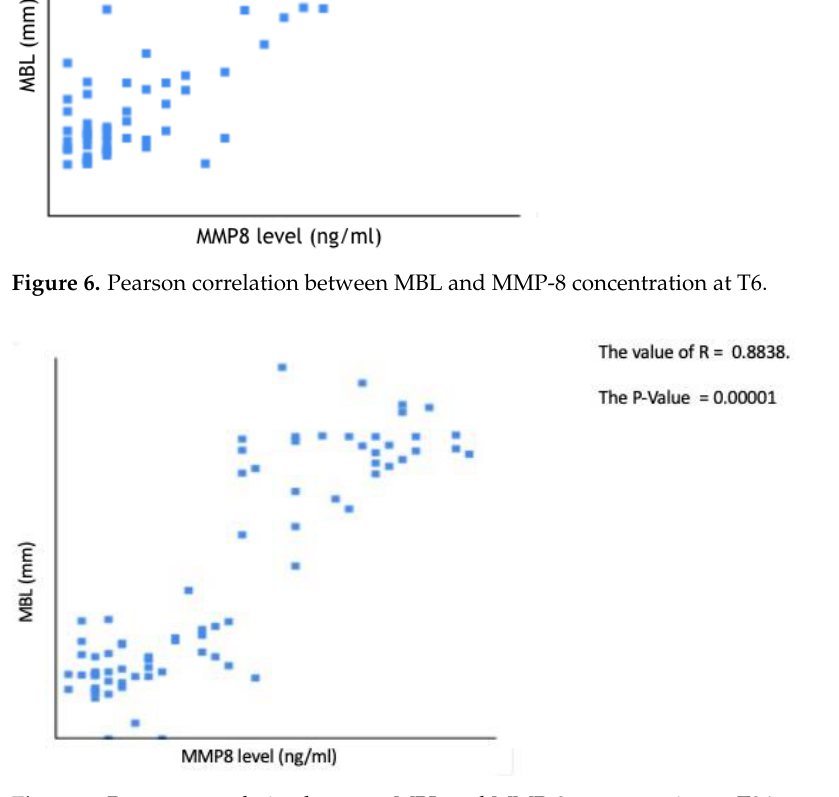
Figure 7. Pearson correlation between MBL and MMP-8 concentration at T24.